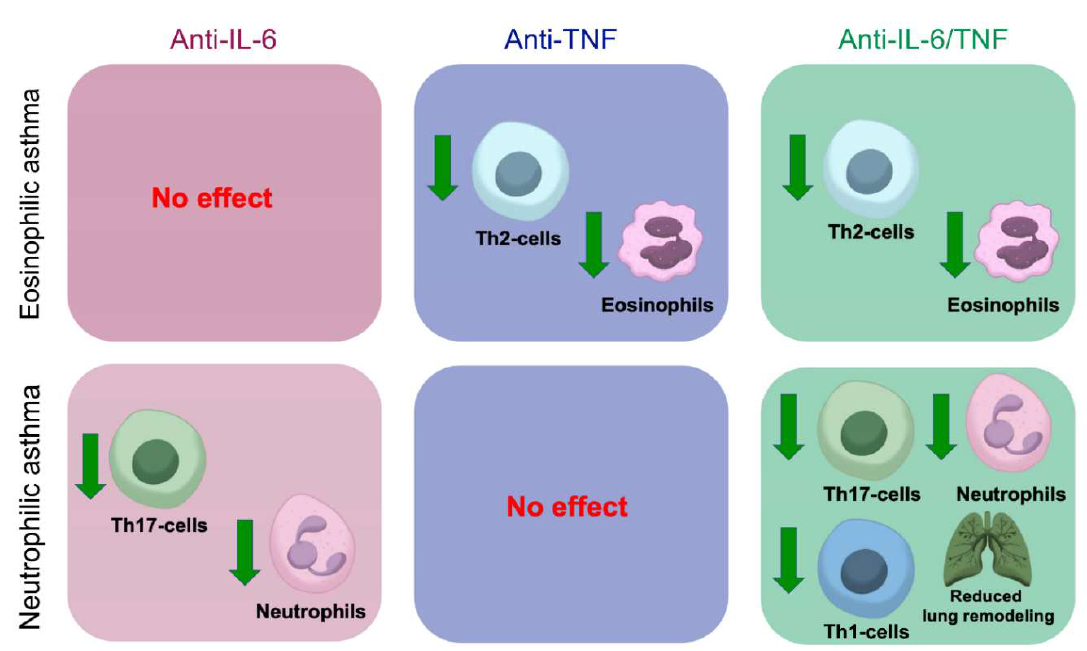
Figure 5. Combined anti-IL-6/TNF administration induces a complex anti-inflammatory effect in the context of severe asthma. Inhibition of IL-6 demonstrated decreased frequency of neutrophils, whereas TNF ablation predominantly suppressed eosinophilic infiltrate into the airways. Moreover, administration of IL-6 neutralizing antibodies prevented the accumulation of Th17- and Th1- cells in the airways, caused by pharmacological TNF ablation. Th2-associated eosinophilia is inhibited under TNF blockade and was not observed under anti-IL-6 administration. On the contrary, combined pharmacological inhibition of IL-6 and TNF had a complex effect consisting of reduction in both Th2-associated eosinophilia and Th1/Th17-mediated neutrophilia and prevention of tissue remodeling in the airways. Therefore, combined anti-IL-6/TNF therapy may be beneficial in inhibiting the key inflammatory responses in allergic airway inflammation and preventing the side effects of monotherapy.